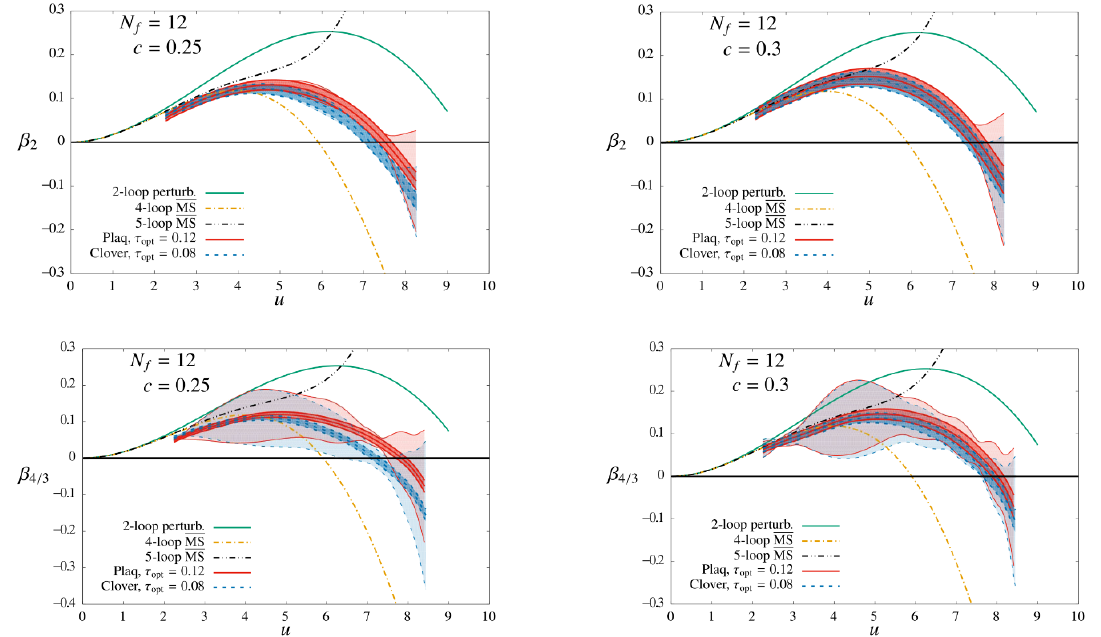
Figure 8 . Continuum-extrapolated discrete (cid:12) function for scale changes s = 2 (top) and s = 4 = 3 (bottom) with c = 0 : 25 (left) and 0.3 (right), plotted in the same style as (cid:12)gure 4 and also